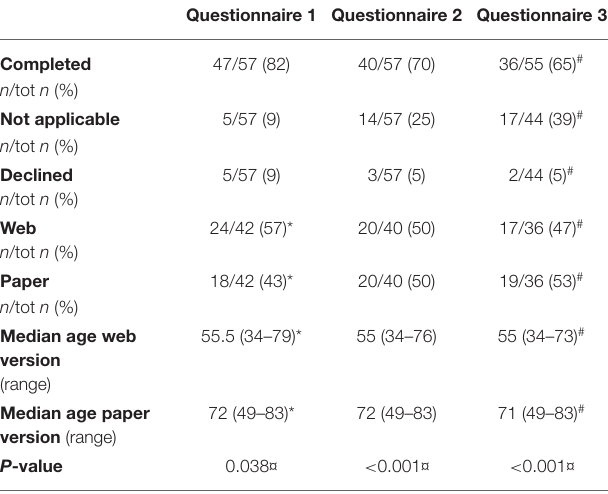
TABLE 5 | Participation in the